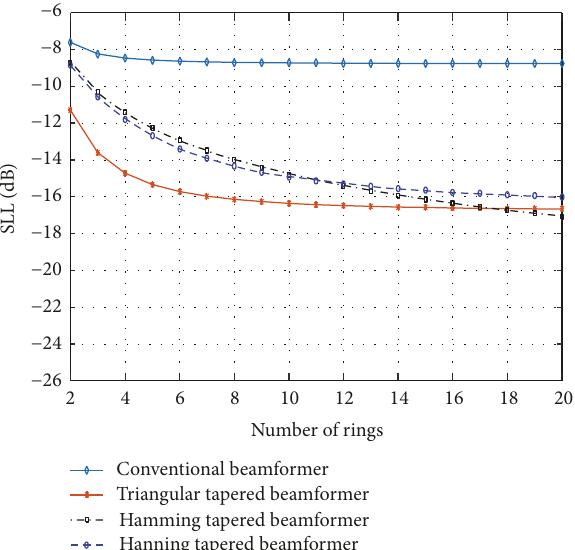
Figure 6: Side lobe level comparison of tapered beamformers using different windows with the variation of the number of rings.